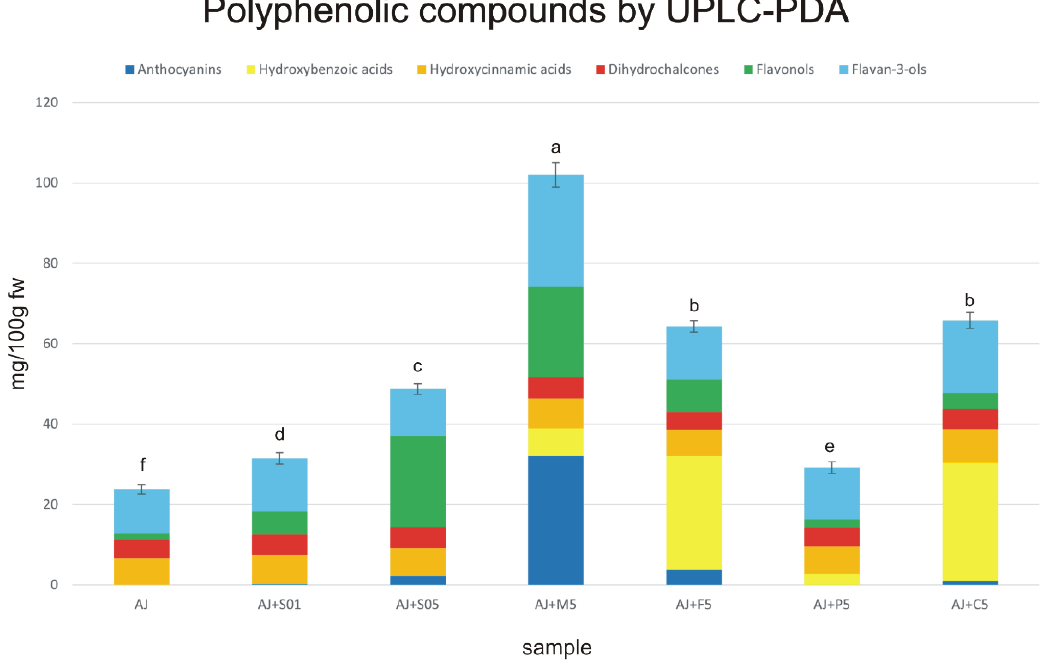
Figure 1. Quantification of phenolic compounds by UPLC-PDA method (mg/100 g fw) in apple juice and enriched apple smoothies. Mean values of the total polyphenolic compounds with different letters (a–f) are significantly different (homogenous groups) at p ≤ 0.05.